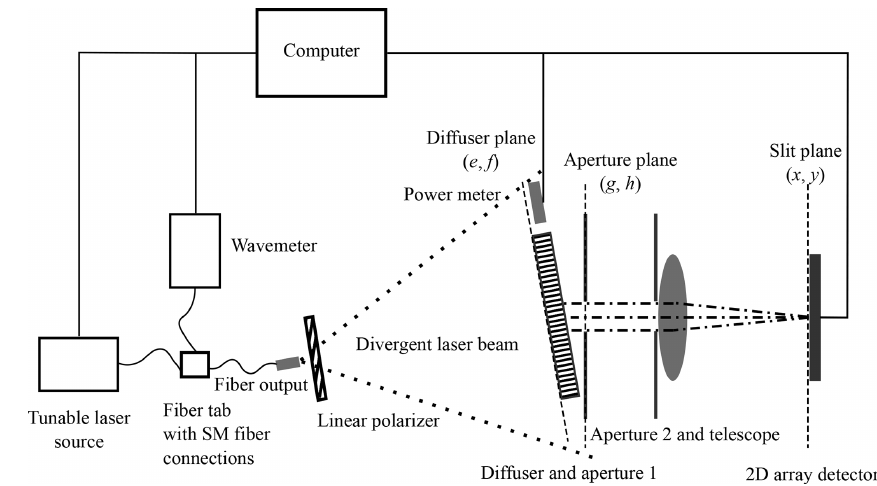
Figure 3. Layout of the experimental setup for measuring diffuser-induced monochromatic speckle patterns in the slit plane. Single-mode fibers are used to connect the laser source with the wavemeter and the output via a fiber tab and are indicated by curved